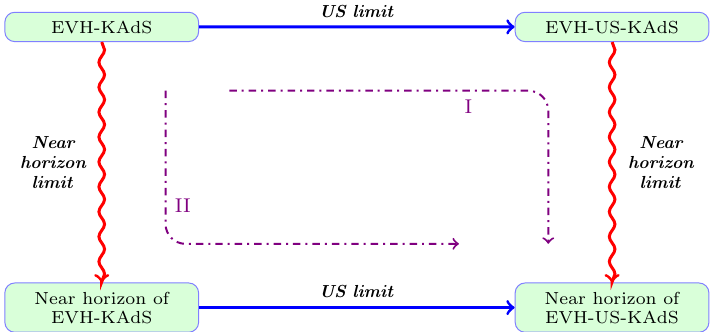
Figure 3 . This diagram shows two different orders of limit for an EVH Kerr-AdS black hole (EVH- KAdS). Horizontal arrows (blue) represent the ultraspinning (US) limit. The vertical ones (red) show the near horizon limit. We show that in both paths the resulting geometry (near horizon of EVH-US-KAdS) are perfectly